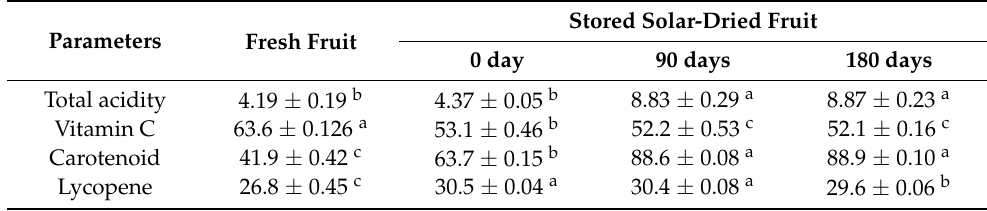
Table 4. Total acidity (%, DM), vitamin C (mg/g, DM), total carotenoid (mg/g, DM), and lycopene content (mg/100 g, DM) of fresh and solar-dried tomato